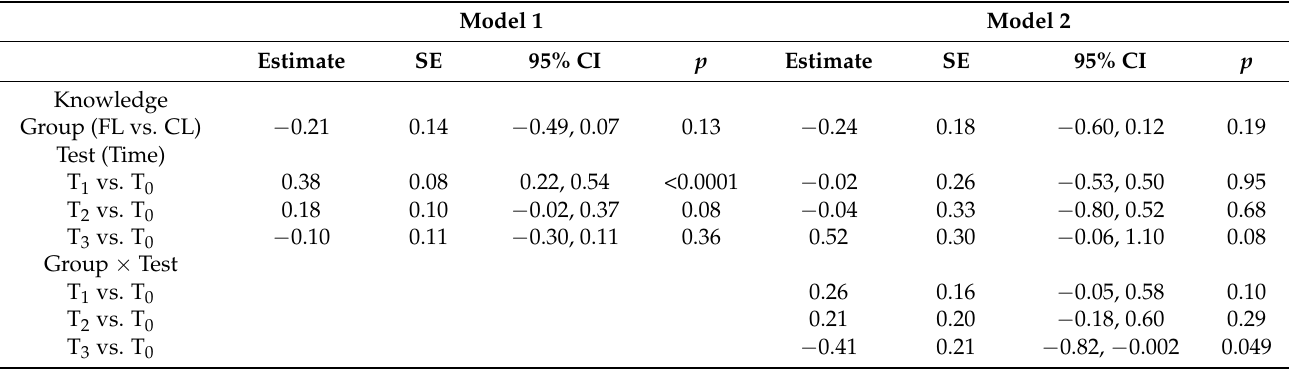
Table 3. Generalized estimating equations (GEEs) analysis of the effectiveness of